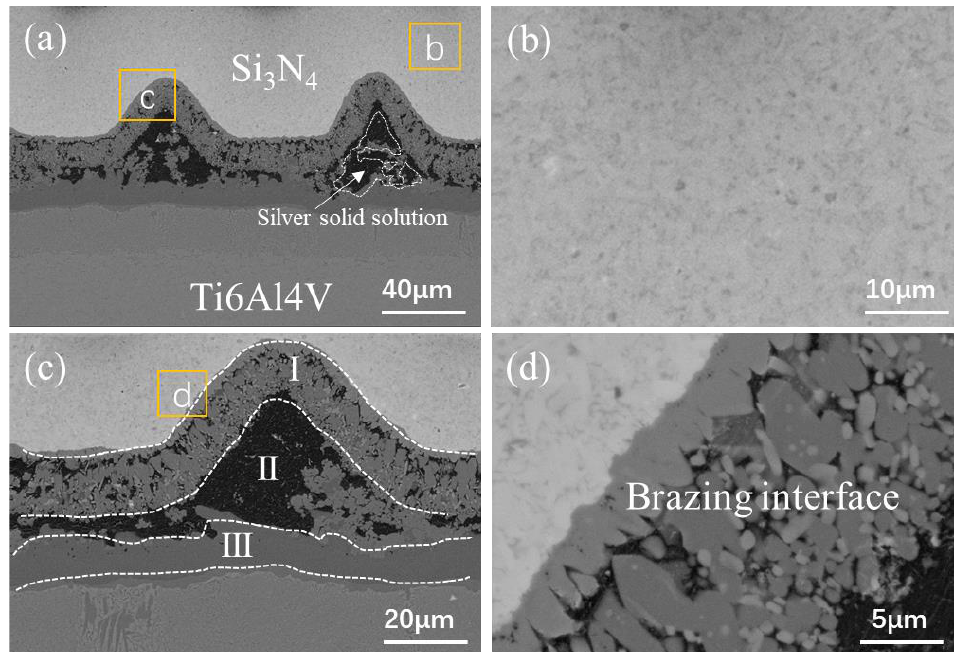
Figure 4. Interfacial microstructure of brazed joints of Si 3 N 4 –titanium alloys with different surface structures: ( a , a1 ) pristine surface; ( b , b1 ) loose surface; and ( c , c1 ) dense surface.